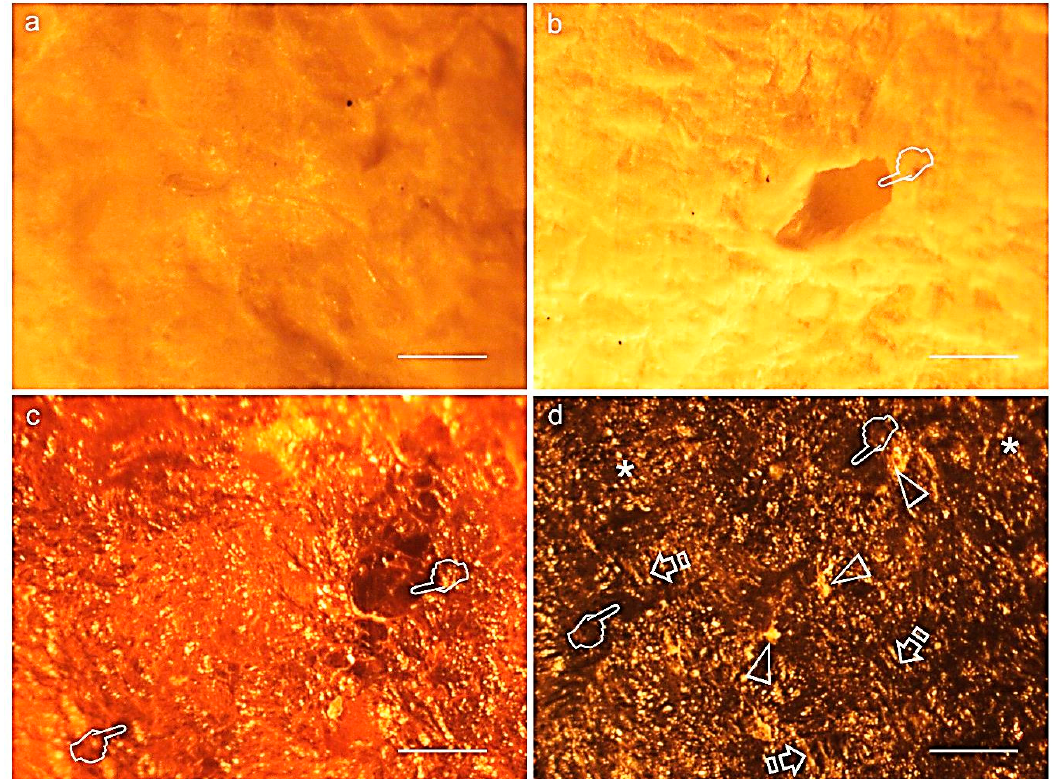
Figure 3. Representative light micrographs of surfaces of Derma Fina membrane at the outer ( a ), inner ( b ) surfaces before immersion and at the inner surfaces after trypsin ( c ) and PBS ( d ) immersion, at 21 d of storage. Single arrows indicate bundles of collagen. Both membrane faces ( b , c ) showed the typical crumpled appearance of immersed membranes. Large diameter pores (wider than 100 µm) were observed at the surface of the membrane (pointers). Shorter and thinner fibers were seen after 21 d in trypsin, and large and thicker fibers characterized the membrane surface after biodegradation in PBS (asterisks). A compact collagen arrangement was interrupted by clusters of circular discontinuities, probably mineral depositions (arrow heads). Scale bar is 1000 µm in ( a , c , d ); and 2000 µm in ( b ).